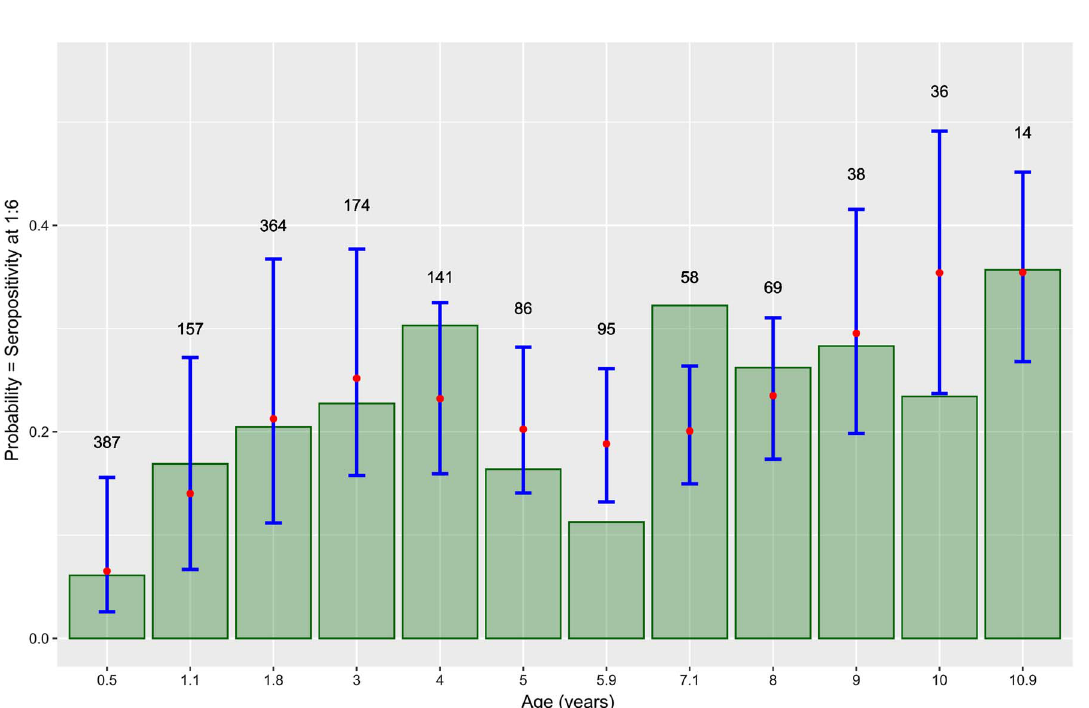
Figure 5. Comparison of observed values versus predicted values by the fi nal model according to age. The observed values are in green bars, while for the predicted values the red point represents the mean prediction and the blue segment the 95% con fi dence interval of the prediction. The number above the blue segment is the number of observations for this particular class of